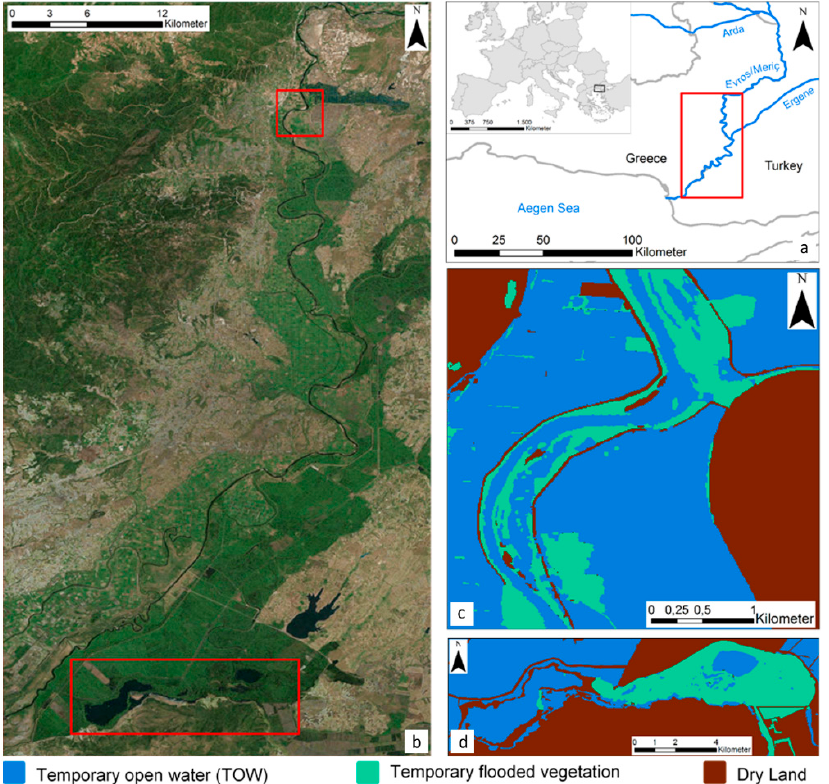
Figure 1. Overview map with the location of the study area (red rectangle) in Greece/Turkey ( a ). Study area in Greece/Turkey (Satellite data: Esri, DigitalGlobe, GeoEye, Earthstar Geographics, CNES/Airbus DS, USDA, USGS, AeroGRID, IGN, and the GIS Use Community) ( b ). The red rectangles represent the reference mask extents for northern ( c ), and southern ( d ) areas. The reference masks based on World-View 2 data (March 11, 2015) ( c ) and RapidEye (April 4, 2015) data ( d ).